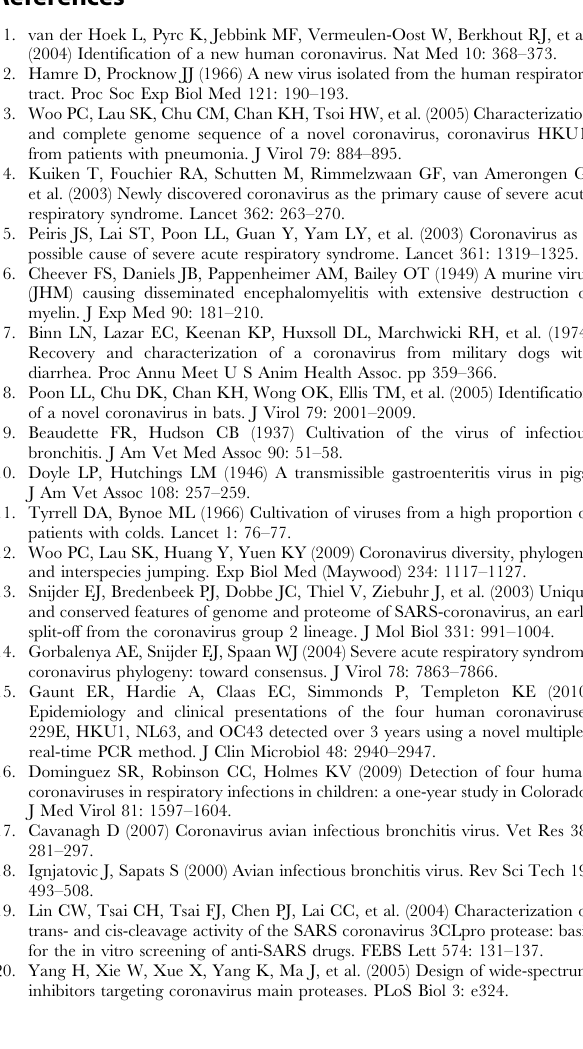
Table S1 Relative activities of HCoV-NL63, HCoV-OC43, SARS-CoV and IBV 3CL pro . ND stands for non-detectable cleavage. The average and the standard deviation of three measurements are shown. Table S2 Correlation between activity of 3CL pro and structural properties of substituting residues. The correlation coefficients and p-values (bracketed) are reported. Table S3 Autocleavage sequences of 3CL pro . PEDV, TGEV, MHV, PHEV stand for porcine epidemic diarrhoea coronavirus,